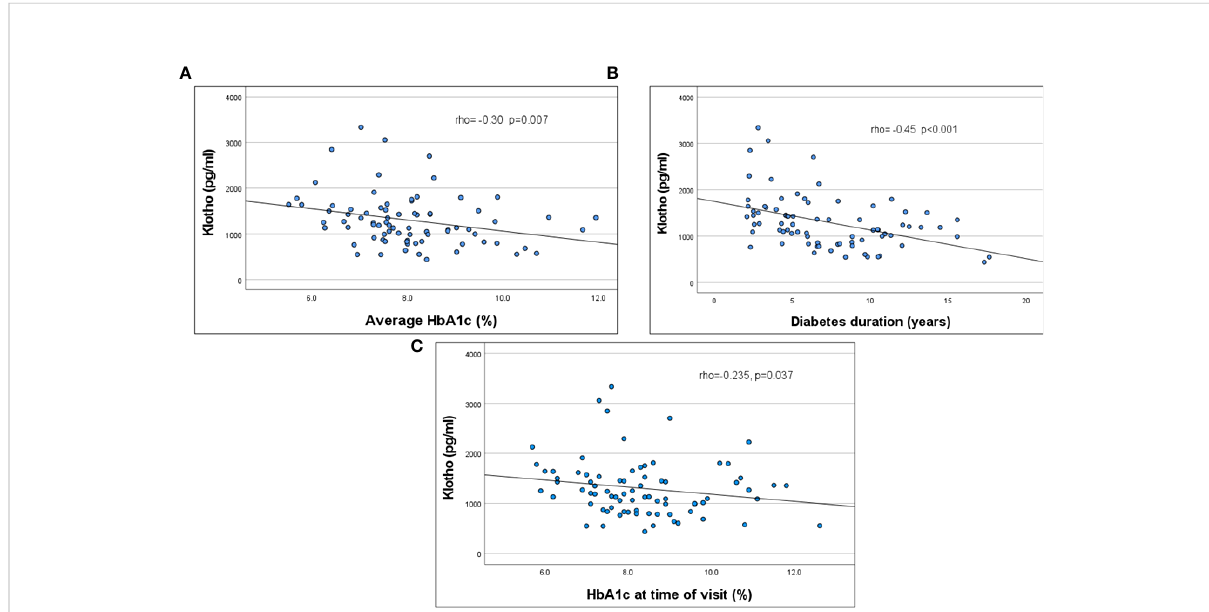
FIGURE 1 Correlation of serum KL levels to HbA1C (2 years average, (A) p =0.007), HbA1C at the time of evaluation ( B , p=0.037) and duration of diabetes ( C , p<0.001).